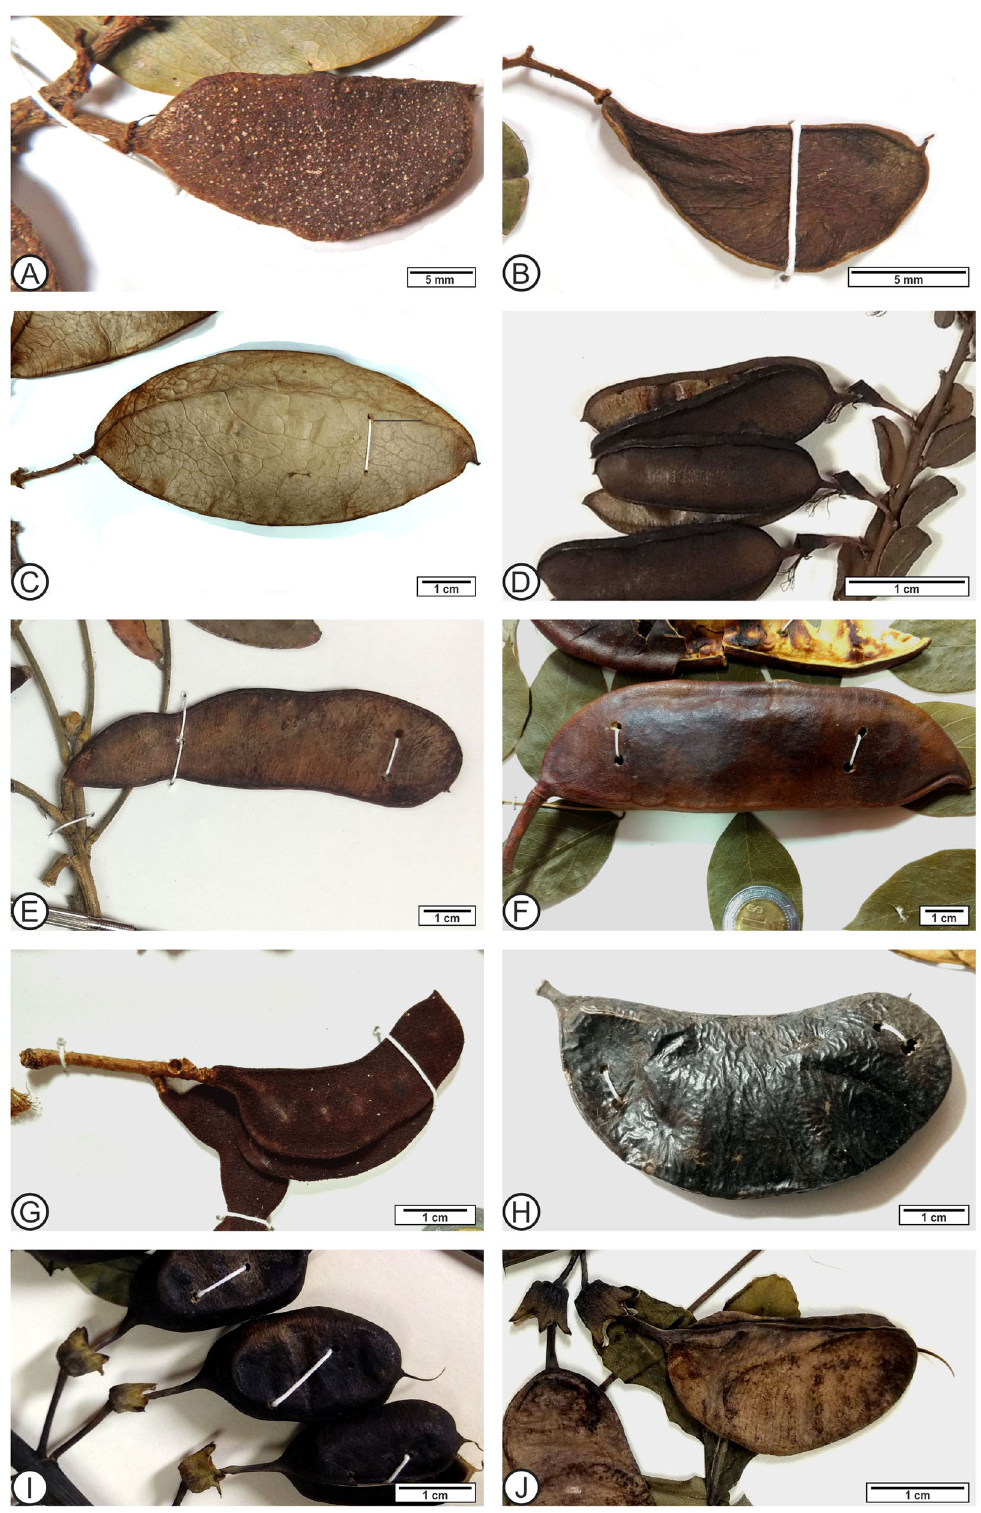
Fig. 4 Extant samples of Fabaceae. a Cynometra oaxacana Brandegee (Detarioideae: 1509871 – MEXU). b Peltogyne mexicana Martínez. (Detarioideae: 1032703 – MEXU). c Barnebydendron riedelii (Tul.) J.H. Kirkbr. (Detarioideae: 1003269 – MEXU). d Bossiaea rhombifolia Sieber ex DC. (Papilionidae: 469928 – MEXU). e Harpalyce arborescens Gray (Papilionidae: 579909 – MEXU). f Gymnocladus dioicus (L.) K. Koch. (Caesalpinioideae: 892167 – MEXU). g Gleditsia amorphoides (Griseb.) Taub. (Caesalpinioideae: 650165 – MEXU). h Microlobius foetidus (Jacq.) M. Sousa and G. (Caesalpinioideae: 1019245 – MEXU). i Baptisia bracteata Elliot (Papilionidae: 962897 – MEXU). j Baptisia lactea (Ra fi nesque) Thieret (Papilionidae: 142687 –